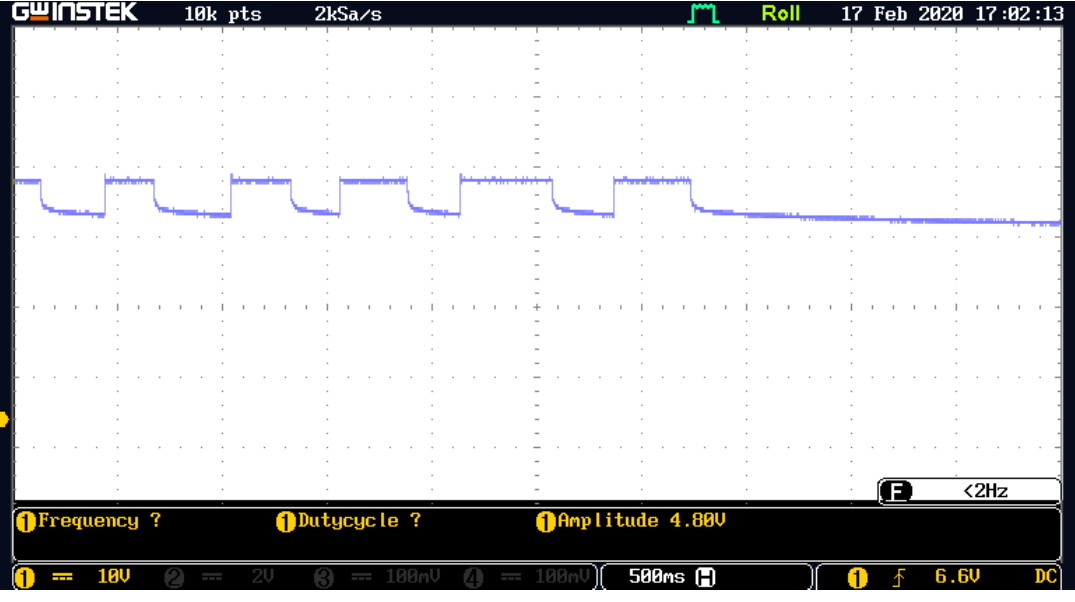
Figure 19. The output voltage ( V output 2 ) under variable changes in the load conditions.